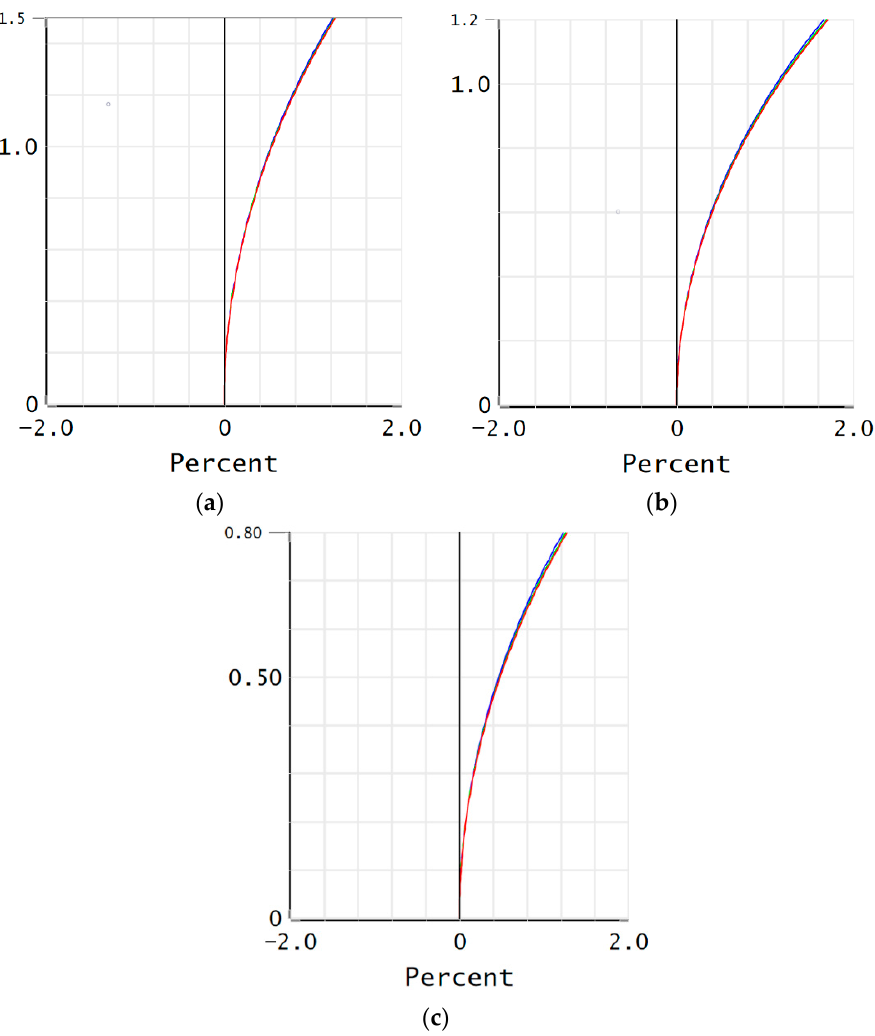
Figure 11. Distortion curves of the zoom system: ( a ) Focal length of the zoom system is 88.3547 mm; ( b ) Focal length of the zoom system is 150.096 mm; ( c ) Focal length of the zoom system is 204.62 mm.